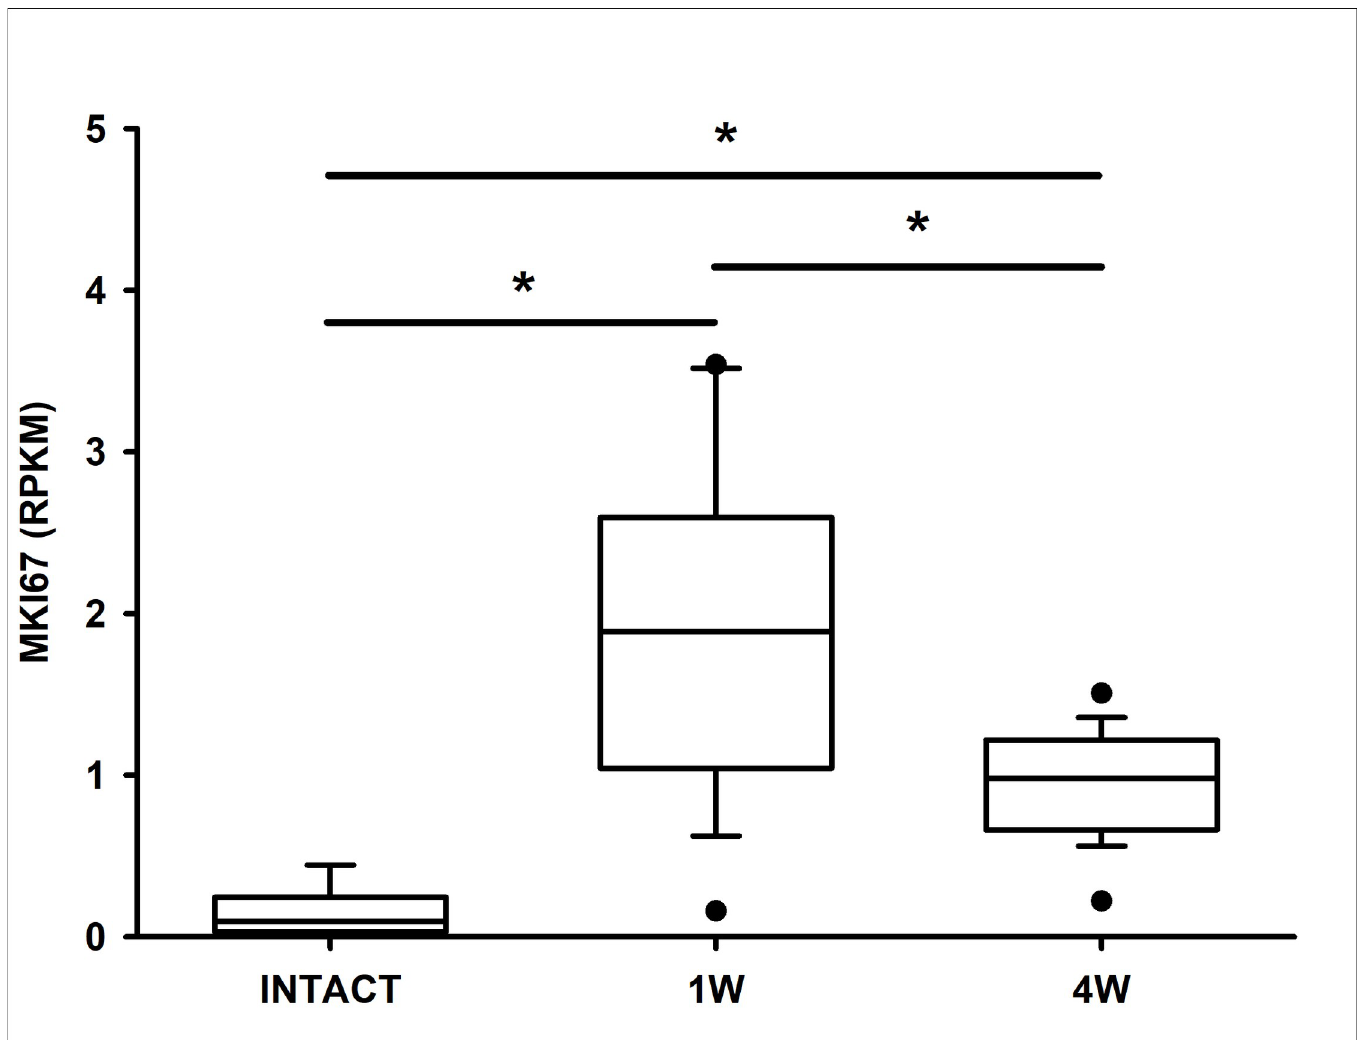
Fig 5. MKI67 expression in reads per kilobase of transcript per million mapped reads across the intact and 1- and 4-week post-injury groups. Black bars and asterisks highlight group comparisons with statistically significant differences.